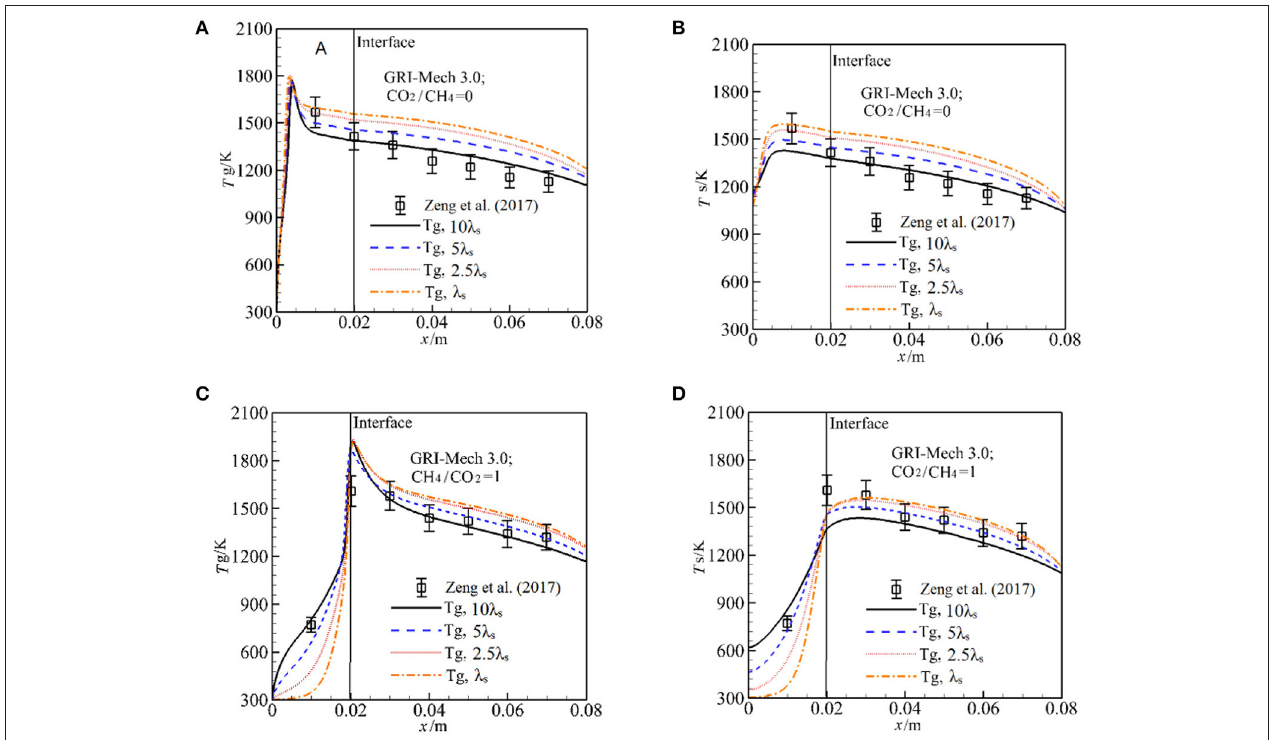
FIGURE 3 | Effect of the packing bed thermal conductivity on gas and solid temperature with GRI-Mech 3.0 for molar ratio of CO 2 /CH 4 = 0, 1. (A) Gas temperature for different solid thermal conductivities at CO 2 /CH 4 = 0; (B) Solid temperature for different solid thermal conductivities at CO 2 /CH 4 = 0; (C) Gas temperature for different solid thermal conductivities at CO 2 /CH 4 = 1; (D) Solid temperature for different solid thermal conductivities at CO 2 /CH 4 =